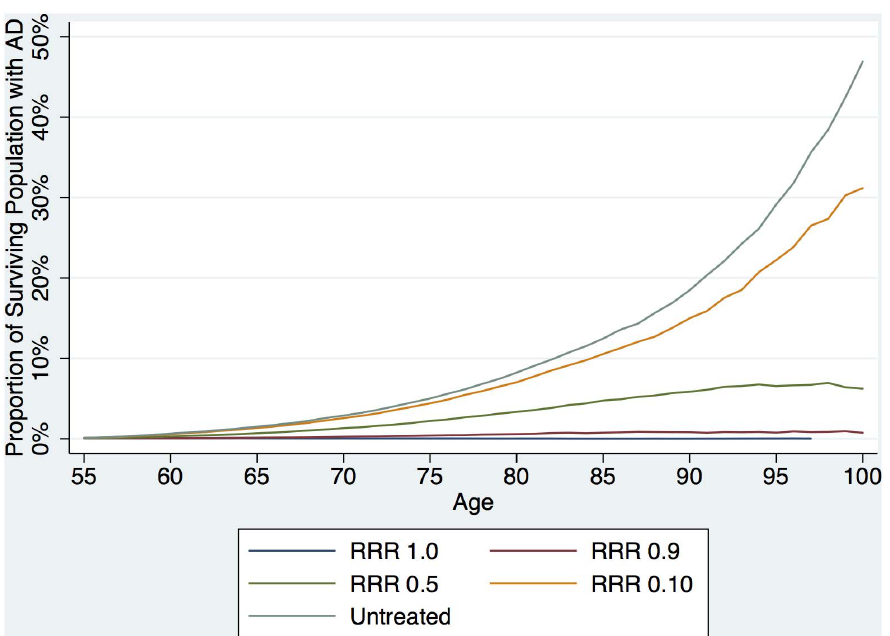
Figure 3. Treatment Effect Validation. Each line represents the proportion of surviving population with AD (estimated prevalence) as the treatment effect size varies assuming all individuals are treated, individuals never discontinue treatment and there is no heterogeneity of treatment